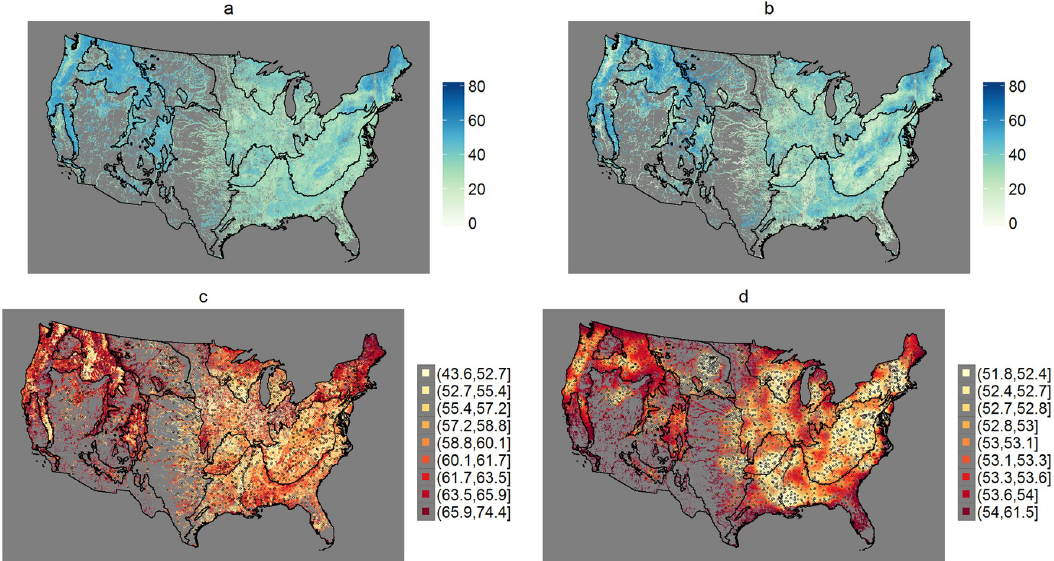
Fig 5. Maps of MMI predictions and prediction errors. The maps show the MMI predictions and lengths of 90% prediction intervals for RF (a,c) and SLM with transformations (b,d). The prediction sites are the 1.1 million perennial stream reaches (catchments) in the NRSA sampling frame. Note the different scales in the maps of prediction interval lengths (c,d).